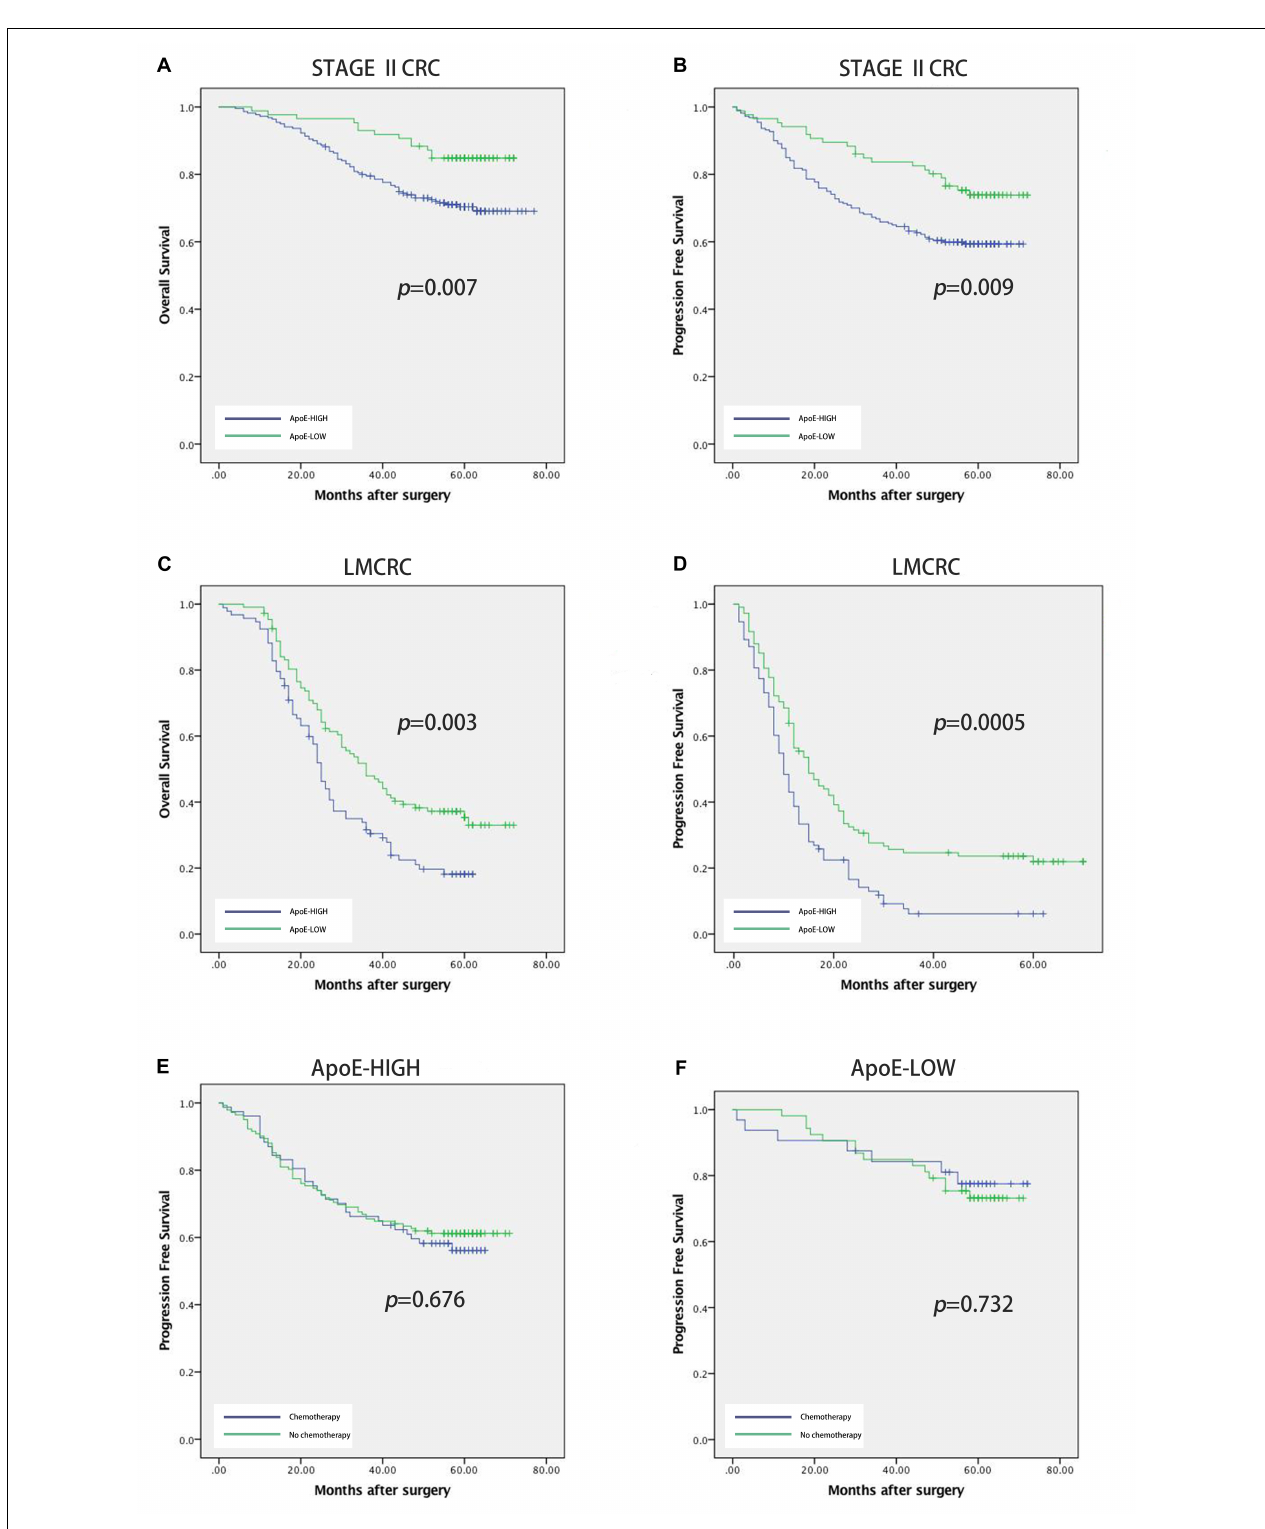
FIGURE 4 | Prognostic power of ApoE in stage II CRC cohort and liver metastatic CRC cohort. Kaplan–Meier analyses of overall survival and progression free survival in patients with CRC based on the expression of ApoE . OS and PFS according to ApoE expression in stage II CRC (A,B) and liver metastatic CRC (C,D) . The relationship between ApoE expression and PFS benefit from adjuvant chemotherapy in patients with stage II CRC. Treatment with 5-FU based chemotherapy was not associated with a higher rate of PFS both in the ApoE high group (E) and the ApoE low group (F) .